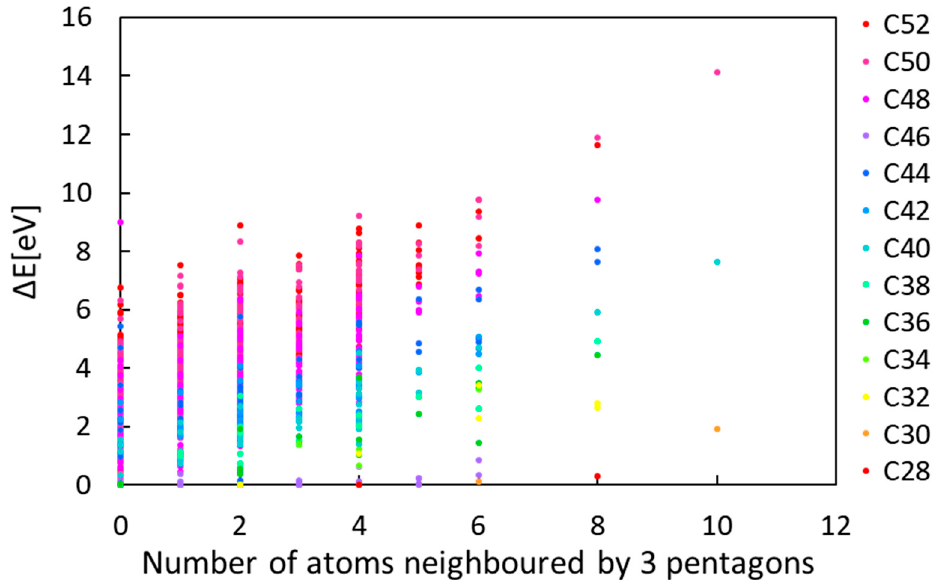
Figure 1. Plot of the number of atoms neighboured by triple pentagons versus energy difference compared to the ground state isomer. The structure instability is, in general, proportional to the number of triple pentagons. For the optimal lowest energy isomer of C x , Δ E = 0.